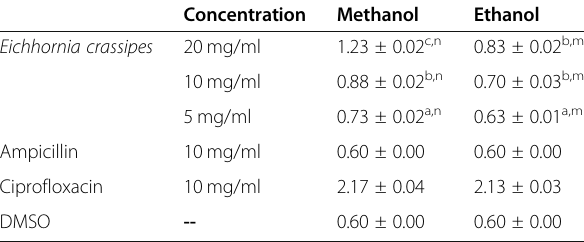
Table 1 Antibacterial activity of ethanol and methanol extracts of E. crassipes against V. harveyi